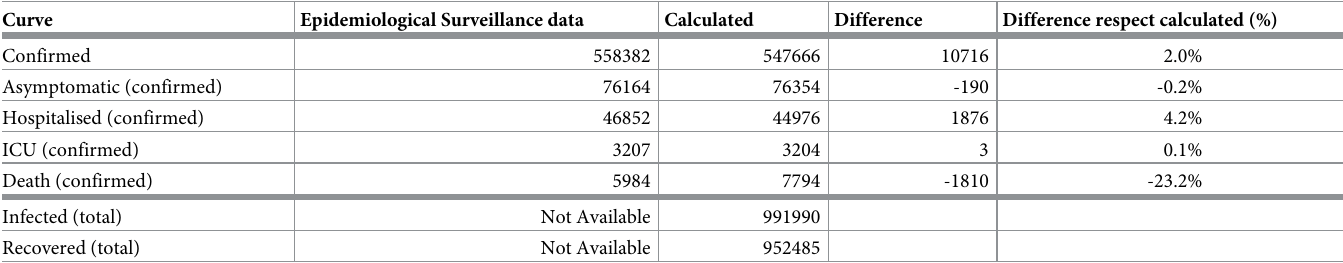
Table 5. Cumulative cases from the start of the second wave to the end of the third wave (from 28 th June 2020 to 28 th March 2021).